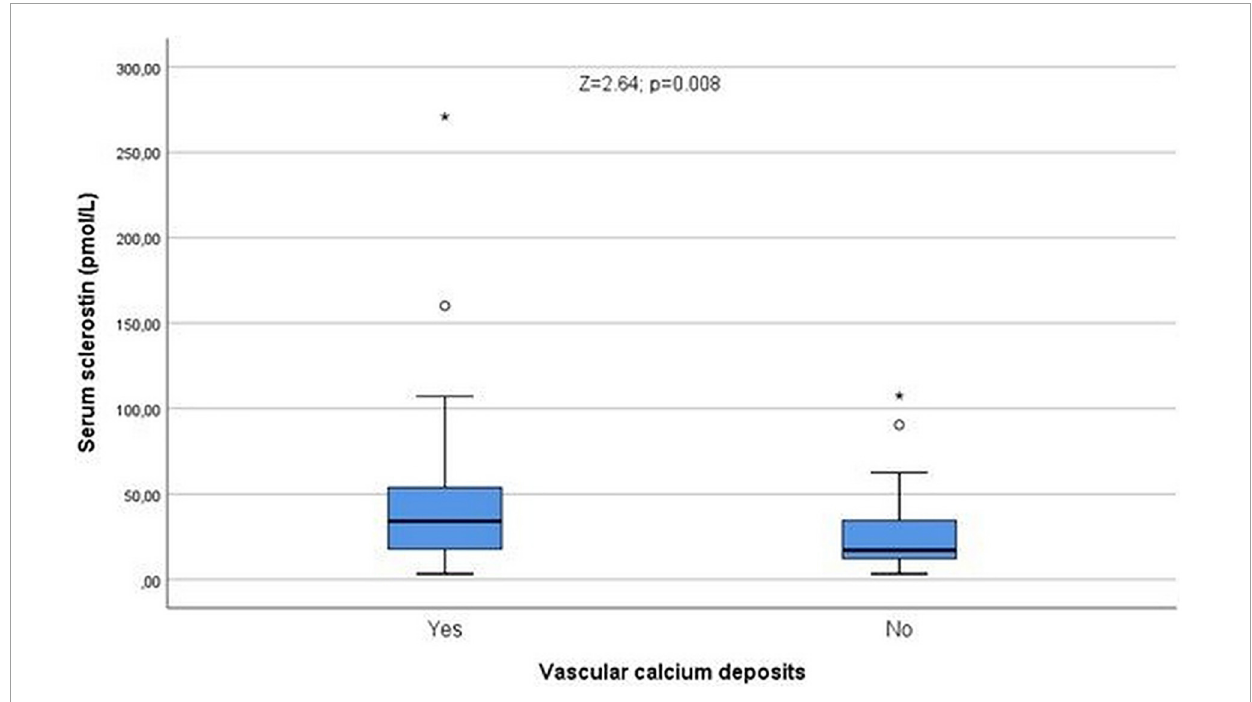
FIGURE4 Serum sclerostin levels were higher in patients with vascular calcium deposits ( Z = 2.64; p = 0.008). ◦ Represent the outliers and *represent the extreme outliers.